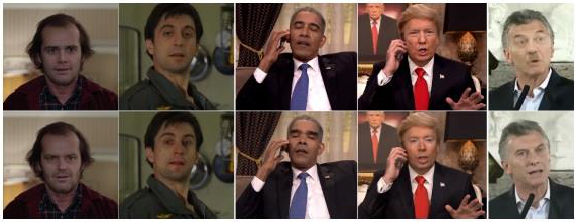
Fig 1. A deepfake manipulate images examples [14] It is critical to comprehend how the Generative Adversarial Network (GAN) generates the DF in order to detect it. GAN takes a video and extracts an image of a person (target) as input and provides a video with the face of target being replace with another person's face (source). Deep learning alongside neural networks being trained on the face cropped photos and target videos provides the backbone of DF, which automatically transfers the source's faces and facial emotions to the target.